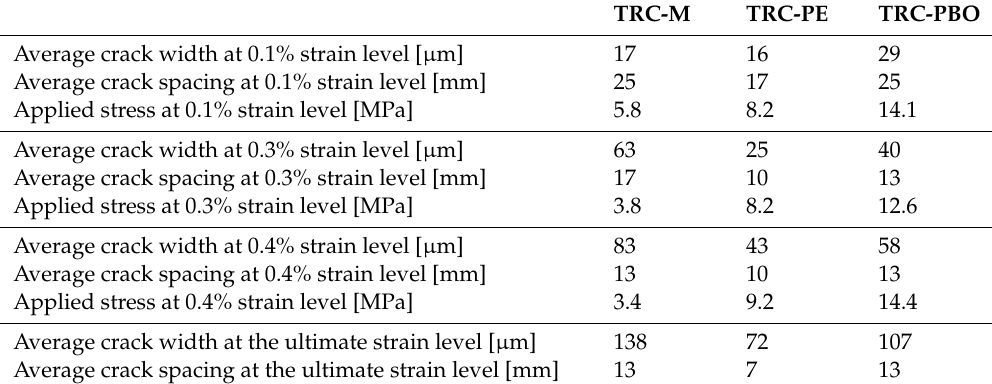
Table 8. Average crack width and crack spacing at the strain levels of 0.1%, 0.3%, and 0.4% for the representative specimens subjected to uniaxial impact tension tests (localization crack